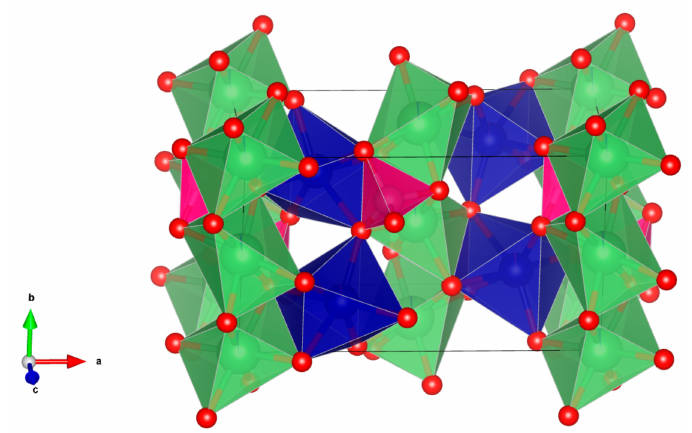
Figure 1. Of the octahedral unit cell of the olivine lattice (green octahedra: LiO 6 units, blue octahedra: TMO 6 octahedra, pink tetrahedra: PO 4 units, TM = transition metals). Red full circles are oxygen atoms, green full circles are lithium atoms, blu full circles are TM